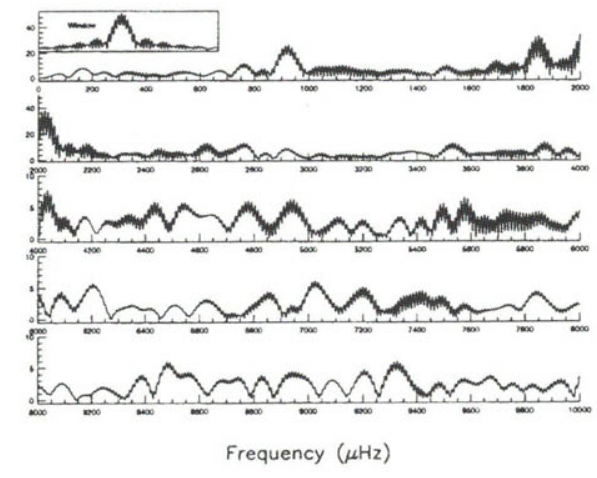
Fig. 19. The FT for the November 1993 data on HL Tau